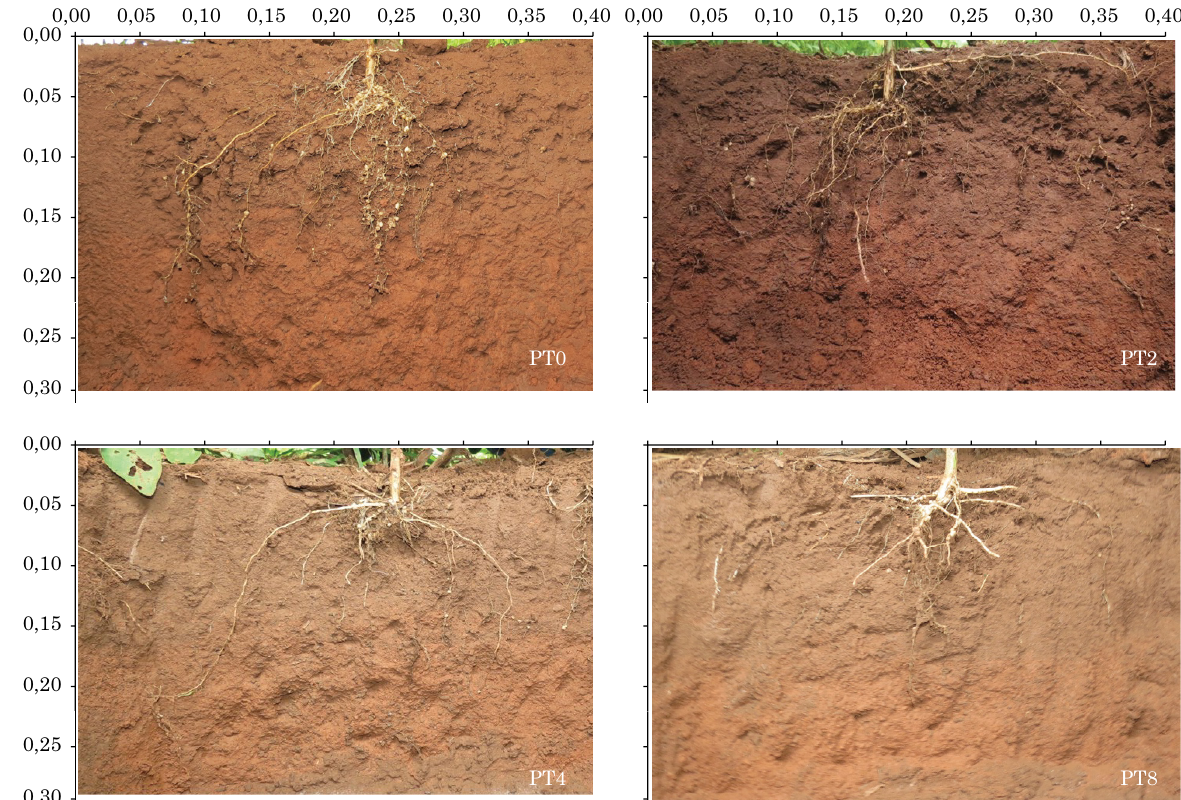
Figura 4. Distribuição das raízes da soja até 0,30 m de profundidade do solo, em decorrência de zero (PT0), duas (PT2), quatro (PT4) e oito (PT8) passadas de